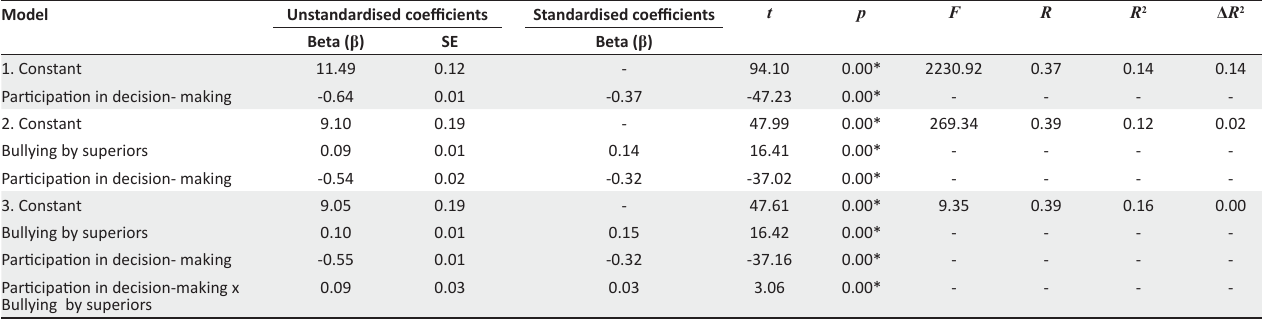
TABLE 5: Hierarchical regression analysis (participation in decision-making) with turnover intention as dependent variable. Model